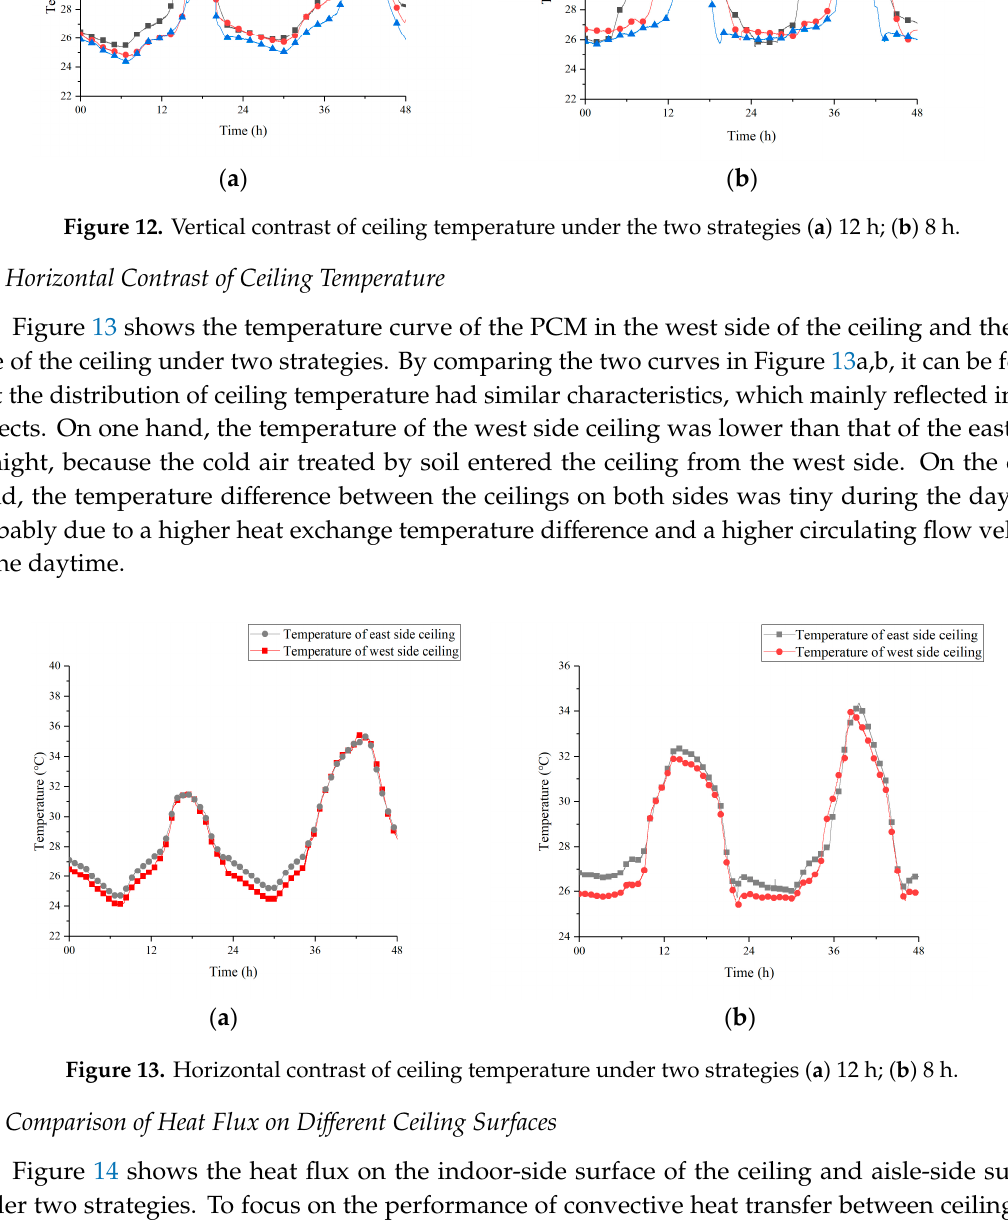
( b ) Figure 14. Heat flux of different ceiling surfaces under two strategies ( a ) 12 h; ( b ) 8 h. Observing the heat flux curve on the aisle-side surface of the ceiling, it could be seen that during the daytime, under the operation of the ceiling channel, the heat flux could maintain above 3 W/m 2 under Strategy 1 while above 2 W/m 2 under Strategy 2. This result proved that the fins effectively strengthen the convective heat transfer effect between ceiling and air. Since the temperature difference between the tunnel air and the PCM was relatively small, the heat flux of aisle-side was lower than that of the daytime during the operation of the EAHE system at night. However, the low heat flux might also be related to the airflow organization in the ceiling tunnel when the EAHE system was running. This would be the key part of our follow-up research. 3.6. Analysis of Phase Transition Duration In the whole experiment, the solidification process was not complete under Strategy 2. Other than that, regardless of the strategy, it was difficult for the bottom layer of the lower ceiling to fully melt during daytime. So, only the phase transition duration of the middle layer under Strategy 1 was analyzed. Figure 15 shows the total time of the phase transition process under Strategy 1. Throughout